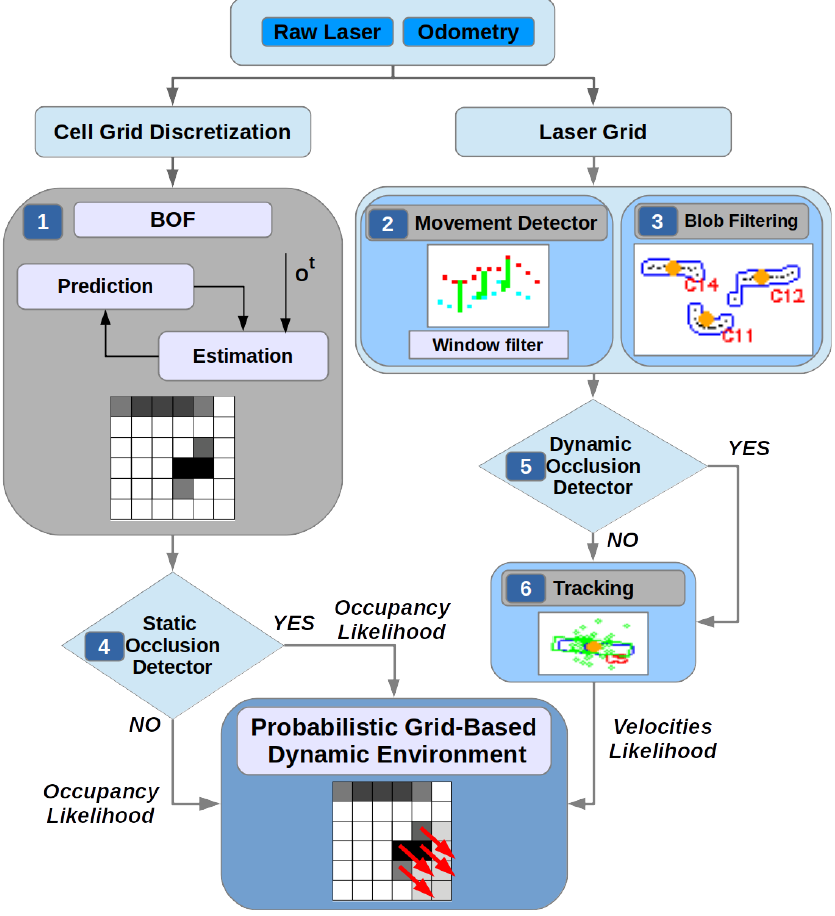
Figure 1. Proposed iDOMap